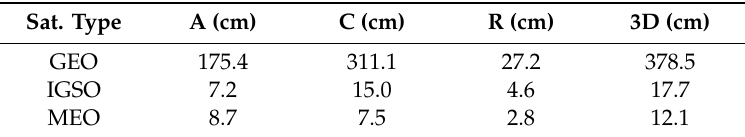
Table 1. Orbit di ff erences of BDS orbits calculated by the Positioning and Navigation Data Analyst (PANDA) and provided by GeoForschungsZentrum (GFZ).